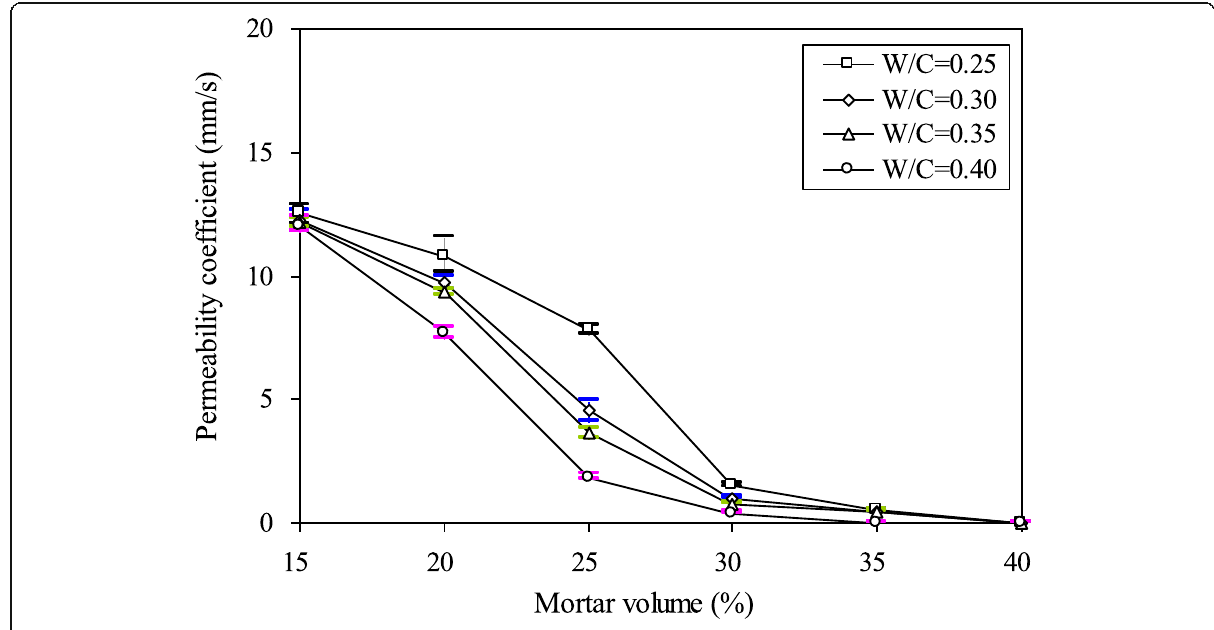
Fig. 7 Unsubmerged permeability coefficient versus mortar volume for different W/C ratios